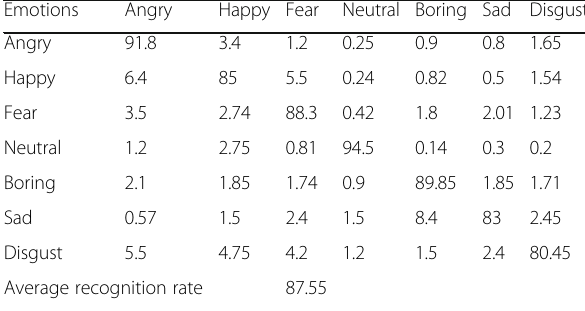
Table 12. According to the results, the optimal ini- tial threshold can be obtained. For CASIA Chinese speech corpus, when the initial threshold is set to 5% or the value in 7~11%, we can achieve the best emotion recognition performance. For the EMO-DB Berlin speech corpus, the best performance can be obtained when the initial threshold is set to 6%. In our experiments, the optimal initial threshold is set to 7% when CASIA Chinese speech corpus is used.